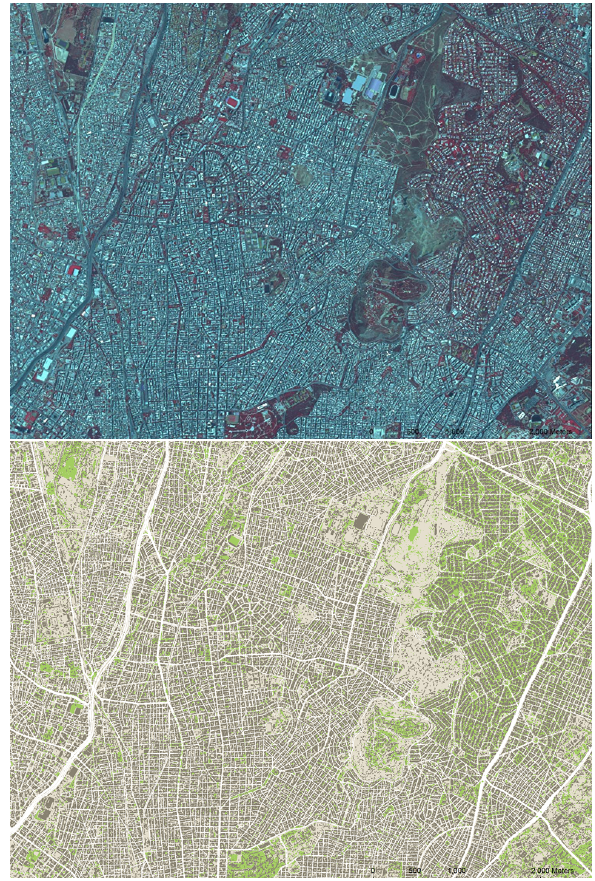
Figure 1: Example of the European settlement information ex- tracted by the GHSL platform from Spot 2.5-m resolution input imagery in Athens (Greece). Top: input image. Bottom: output of the automatic data classification. Dark brown: built-up ar- eas (buildings), green: vegetated open spaces, white: other open